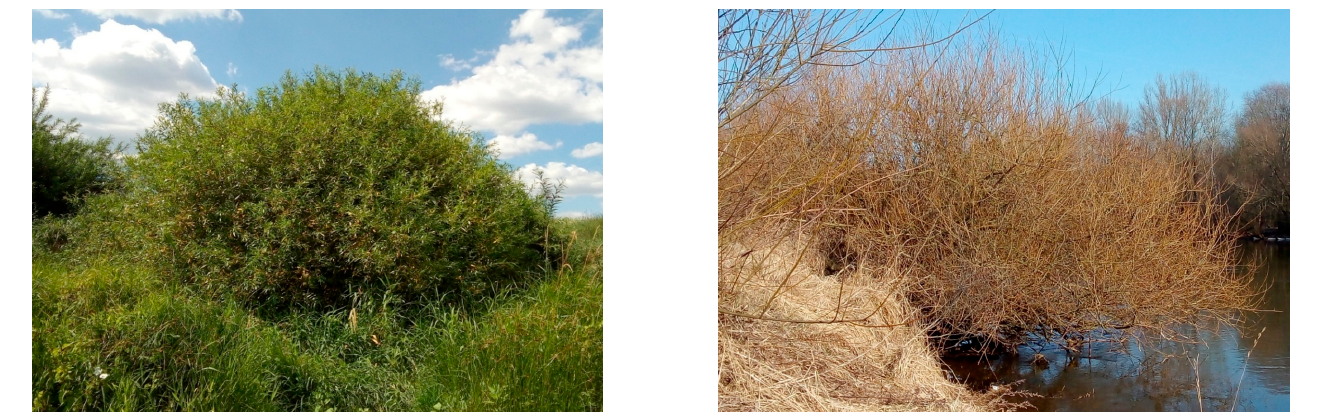
Figure 4. View of shrub 3 during the vegetation conditions (( left photo )—14 July 2020) and the non-vegetation conditions (( right photo )—13 December 2020).